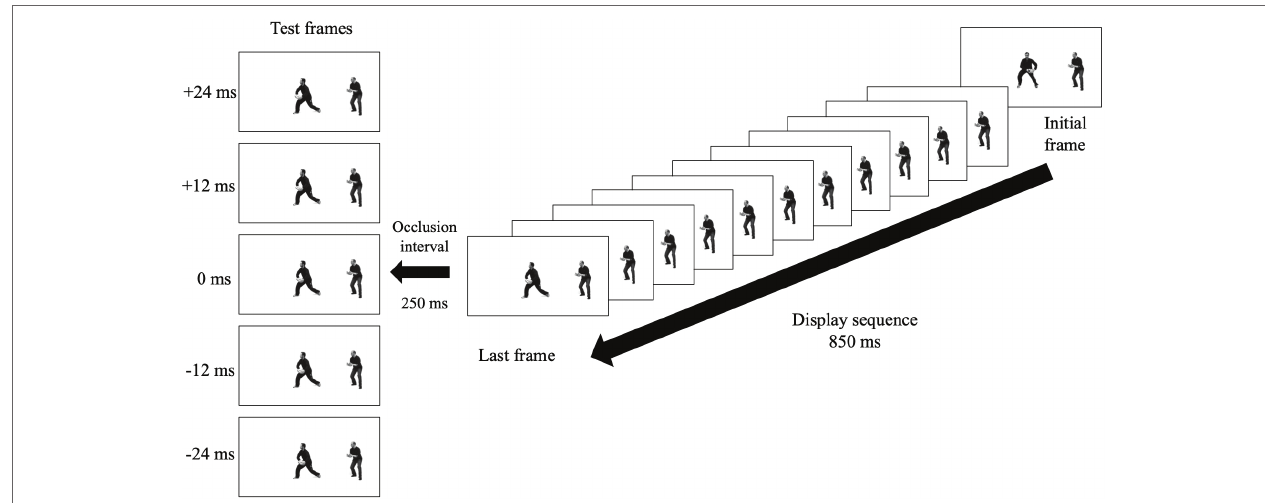
FIGURE 1 | A schematic representation of a trial in the leftward “away” condition. Both the passer and receiver appeared at the same time in the initial frame. The sequence then displays the series of images depicting the passer performing the action either toward or away from the receiver for 850 ms to the position of the last frame prior to disappearing for an occlusion interval of 250 ms and then re-appearing at one of five test